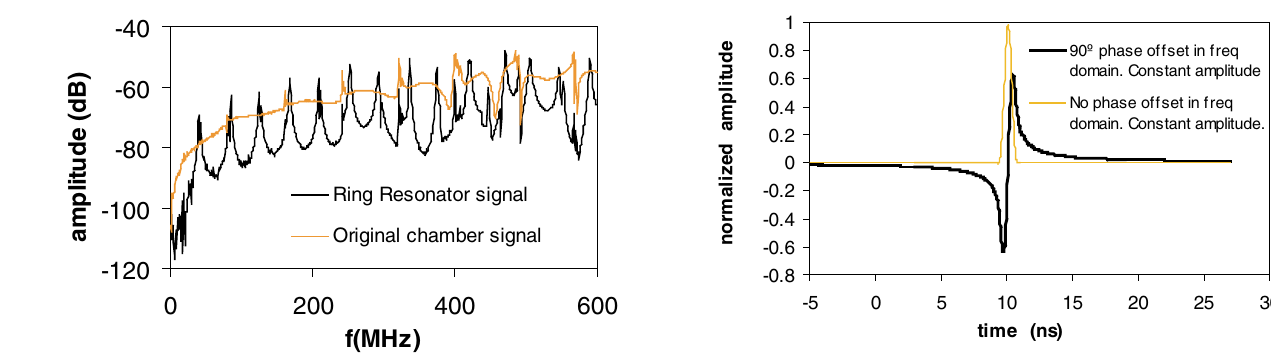
FIG. 12. (Color) Amplitude of the signal seen in a button pickup on the top of the chamber as a function of frequency. The effect of the RR (black line) is compared with the original chamber (orange line). In this plot, the distance between peaks is slightly greater than 40 MHz because the cable length of the actual RR was not exactly 25 ns.